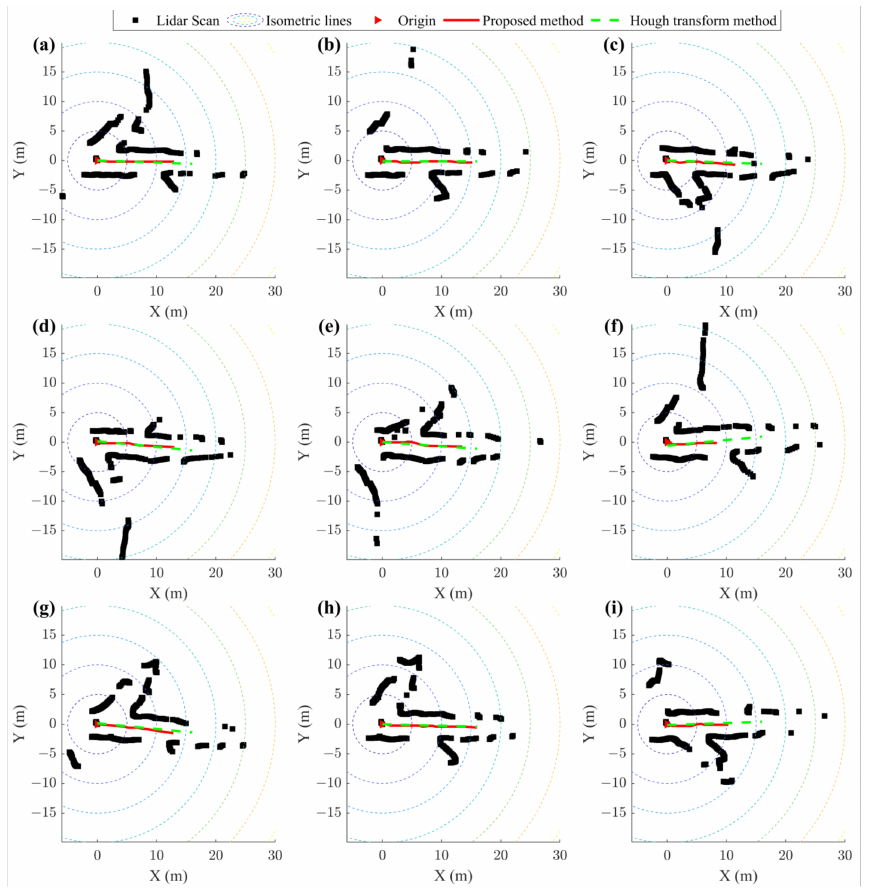
Figure 14. The local path planning of different methods for dataset 2, in which the red lines and the green lines in ( a – i ) are shown as the local path planning of the proposed method and Hough transform method,